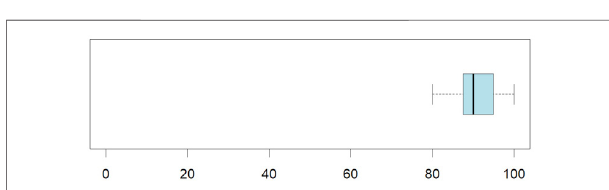
FIGURE 4 | Boxplot of the SUS scores. Mean: 90, sd (cid:1) 5.7.